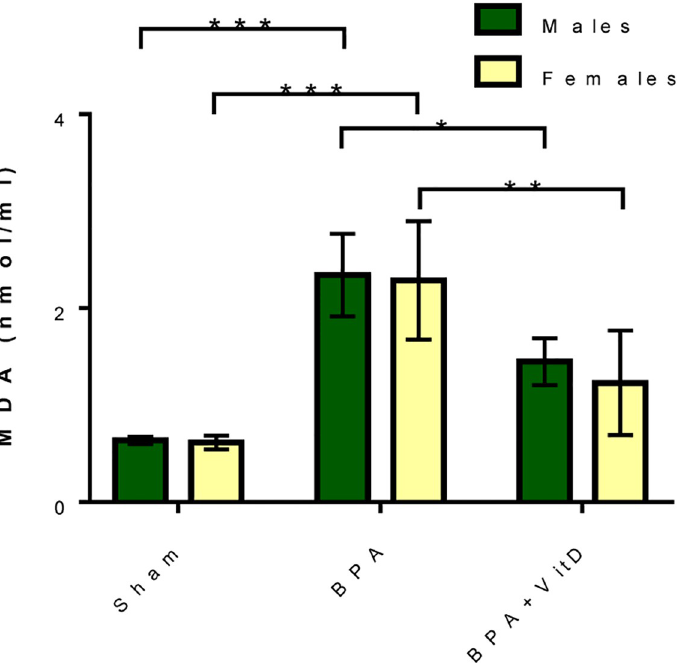
Fig 9. VitD reduces BPA-induced lipid peroxidation. Data are represented as mean ± SD (n = 12), and P < 0.05 is represented as � , P < 0.01 is represented as �� , and P < 0.001 is represented as ��� .